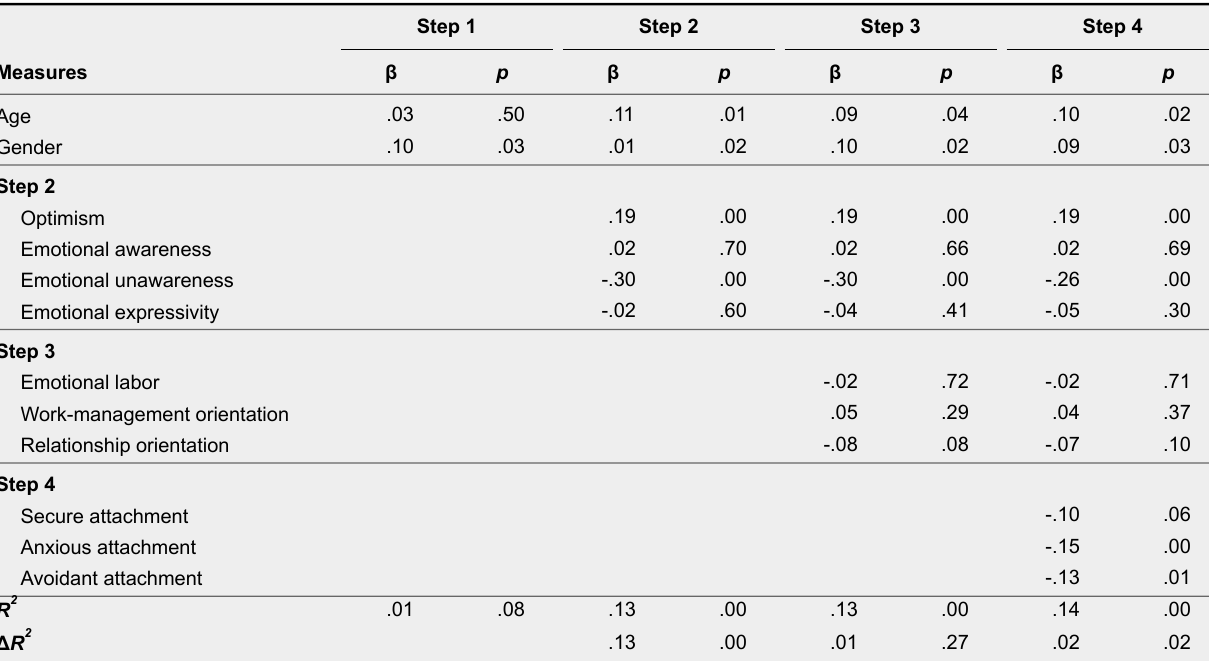
Hierarchical Multiple Regression of Job